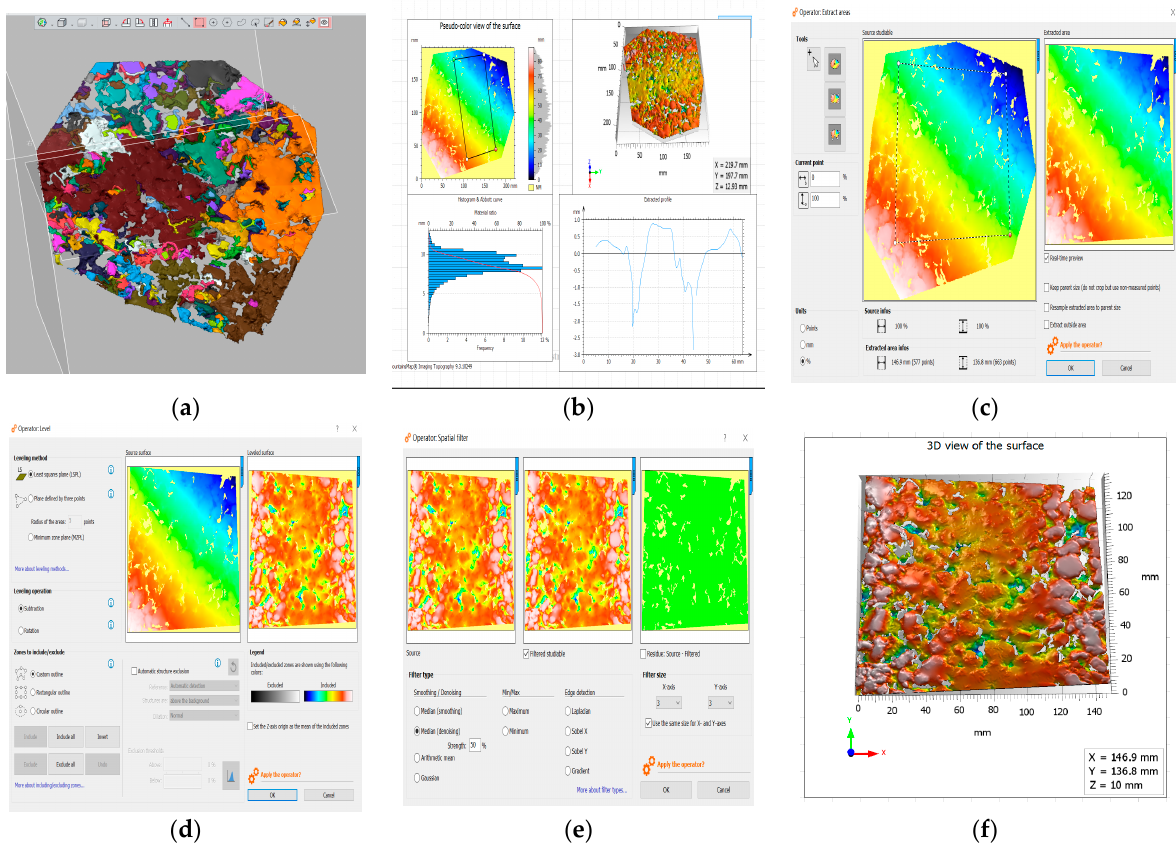
Figure 10. Calculation process for asphalt pavement surface 3D texture: ( a ) processing image; ( b ) importing cloud fi les; ( c ) extracting valid areas; ( d ) applying least squares plane levelling; ( e ) performing median- fi ltering noise reduction; ( f ) generating 3D visualised views.